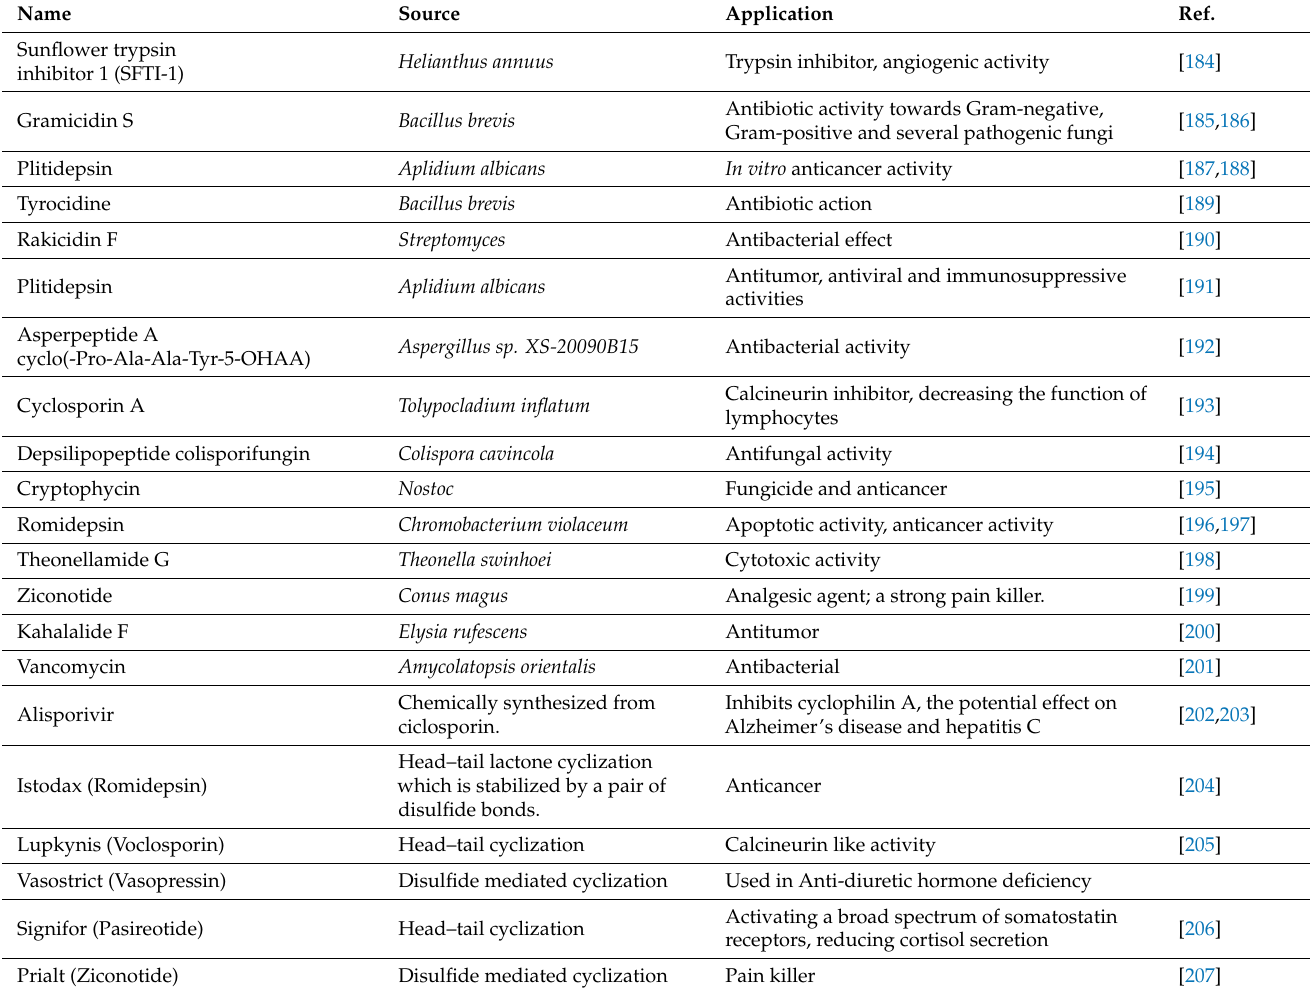
Table 4. Some examples of naturally extracted and chemically synthesized cyclic peptides with their